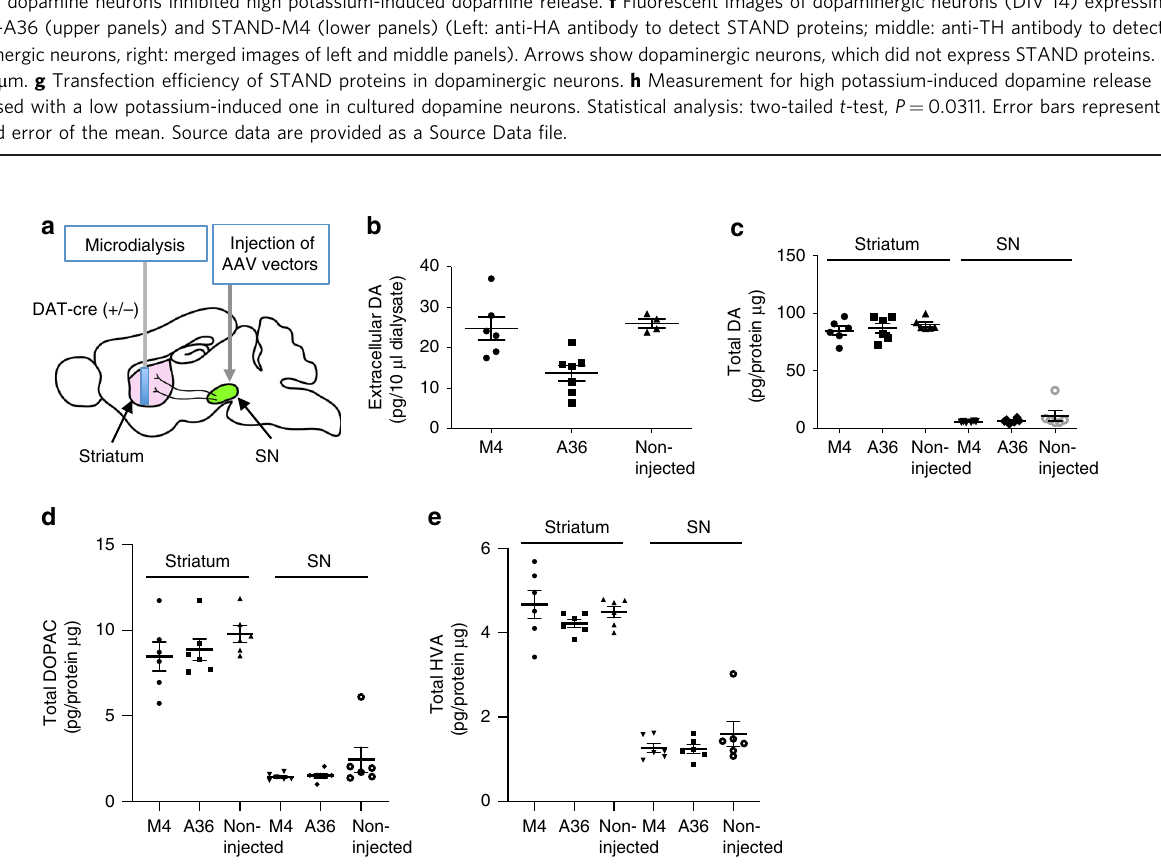
Fig. 7 STAND-A36 inhibits striatal dopamine release. a – e Intracellular expression of STAND-A36 decreases basal dopamine release in the striatum in vivo. a Microdialysis was performed in the striatum of the right cerebral hemisphere of mice 33 days after AAV injection into the SNc. b Average basal extracellular dopamine levels in the striatum of awake mice were measured every 10 min over a 60-min period using microdialysis (M4: n = 6 mice/group, A36: n = 7 mice/group, non-injected: n = 4 mice/group). Statistical analysis: two-tailed one-way ANOVA, F (2, 14) = 9.2457, P = 0.002757, A36 vs. M4, P = 0.0071; A36 vs. non-injected, P = 0.0079; M4 vs. non-injected, P = 0.9352. c – e Total dopamine, dopamine metabolite (DOPAC and HVA) levels in the striatum and SNc of the right cerebral hemisphere of mice with or without an injection of AAV vectors ( n = 6 mice/group). Statistical analysis: two-tailed one-way ANOVA, c Dopamine in striatum, F (2, 15) = 0.5833, P = 0.5702; dopamine in SN, F (2, 15) = 1.2156, P = 0.3241; d DOPAC in striatum, F (2, 15) = 0.99535, P = 0.392734; DOPAC in SN, F (2, 15) = 1.633946, P = 0.228045; e HVA in striatum, F (2, 15) = 1.0771461, P = 0.3655; HVA in SN, F (2, 15) = 1.1143889, P = 0.353814. Error bars represent standard error of the mean. Source data are provided as a Source Data fi we investigated the effect of STAND-Y13-259 on this interaction interferes with the interaction of activated Kras and Raf1 by using 293 T cells. Kras- and STAND-Y13-259-expressing vectors were co-transfected into 293 T cells, and the cell lysate was subjected to co-immunoprecipitation and GST-pulldown analysis (Fig. 9f – h). Co-immunoprecipitation revealed that intracellular STAND-Y13-259 interacts with Kras, but STAND-A36 does not (Fig. 9f). The proteins that precipitated with puri fi ed GST-fused Raf1-RBD (GST-Raf1-RBD) were analysed using Western blot- ting (Fig. 9g). Co-precipitation of Kras with GST-Raf1-RBD was signi fi cantly decreased in cells expressing STAND-Y13-259 when compared to those expressing STAND-A36 or the mock vector control (Fig. 9g, h), indicating that intracellular STAND-Y13-259